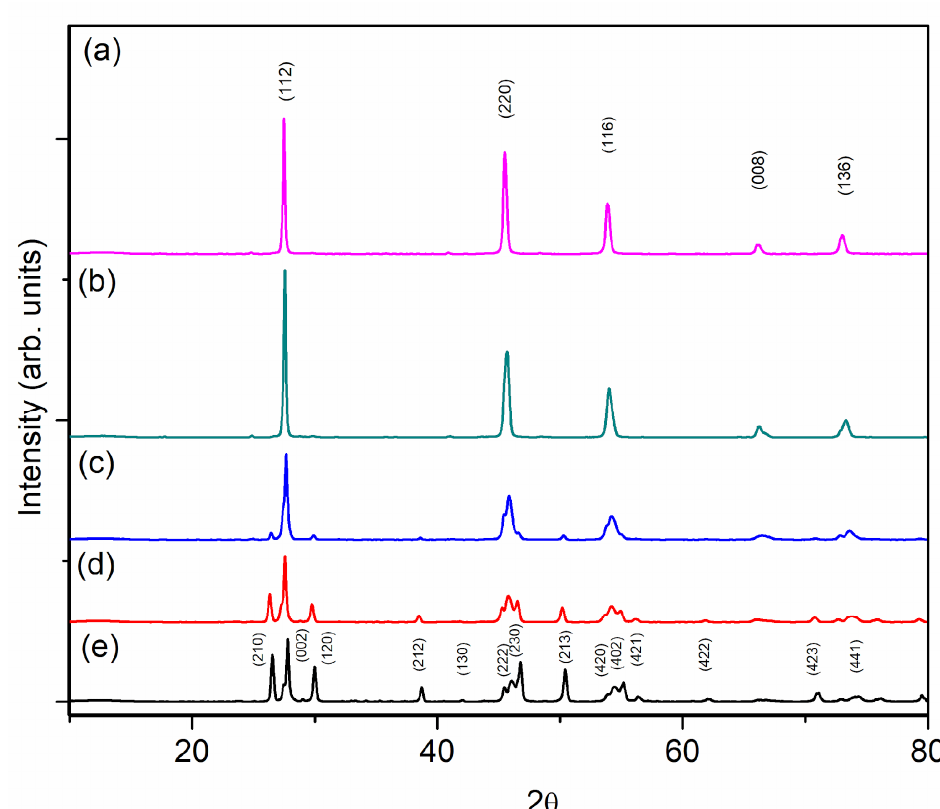
Figure 1. X-ray powder diffraction patterns for Cu 2 ZnSn 1 − x Si x Se 4 , 0.2 ≤ x ≤ 0.8 (a–e).